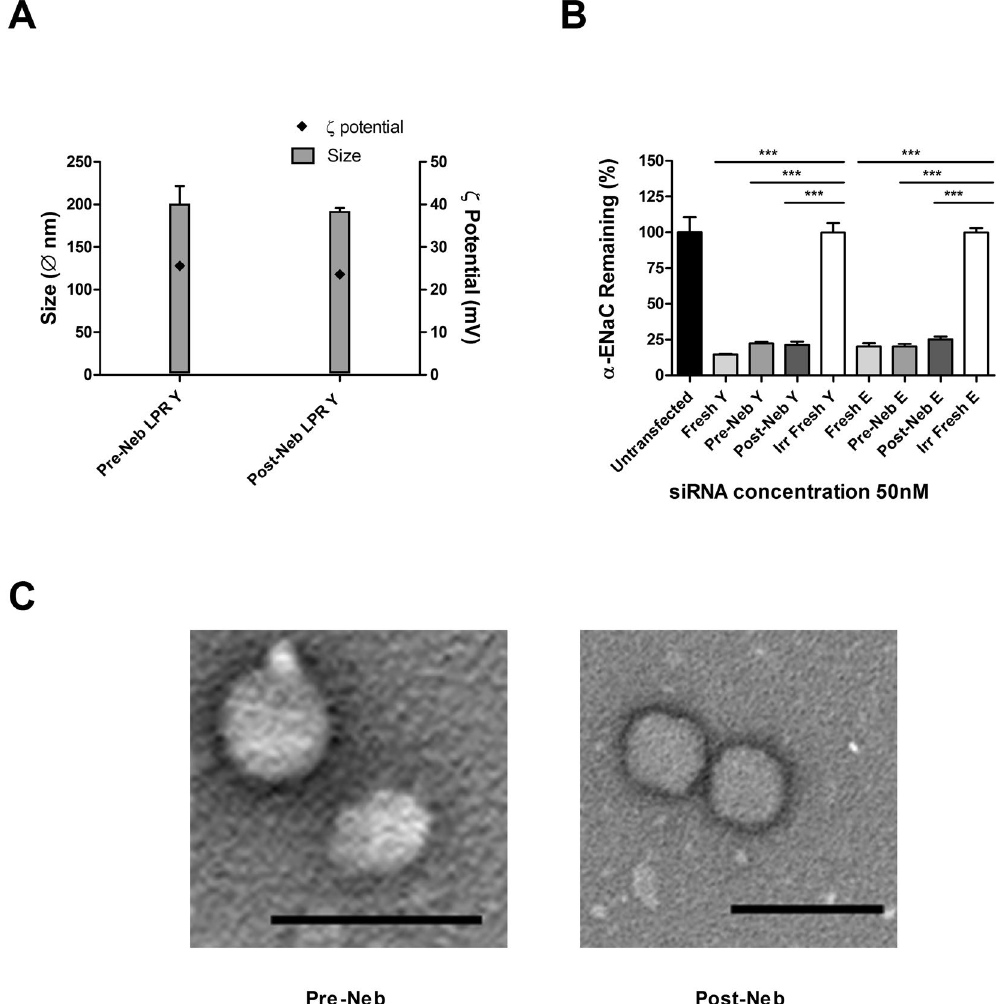
Figure 4. Nebulised LPRs. LPR particles were formulated at a 1:4:1 ratio of DOTMA/DOPE, peptide either Y or E and 100 μ g of siRNA in 2 ml volume of H 2 O. ( A ) The particles sizes and the ζ potentials were assessed. The LPRs displayed sizes between 192 and 200 nm in diameter while the ζ potentials were between 23.6 and 25.6 mV. ( B ) The s ilencing capability of LPRs was detected after transfection of human airway epithelial (HAE) cells. The transfection ability of LPRs containing either peptide Y (n = 5) or peptide E (n = 6) and 50 nM siRNA was measured comparing the un-nebulised freshly made LPRs, the pre-nebulisation and post-nebulisation formulations relative to the freshly made non-targeting/irrelevant siRNA. Liposome-peptide Y- RNA nanoparticles freshly prepared or pre- and post-nebulisation displayed a silencing efficiency of 85.4%, 77.7% and 78.5%, respectively. Peptide E-LPRs showed similar levels of ENaC silencing 79.8% mediated by freshly prepared and pre-nebulisation, and 74.7% mediated by the nebulised LPRs. Statistically significant differences were determined as *** P ≤ 0.001. ( C ) LPRs pre- and post-nebulisation were also assessed by transmission electron microscopy (TEM). Size bars are 500